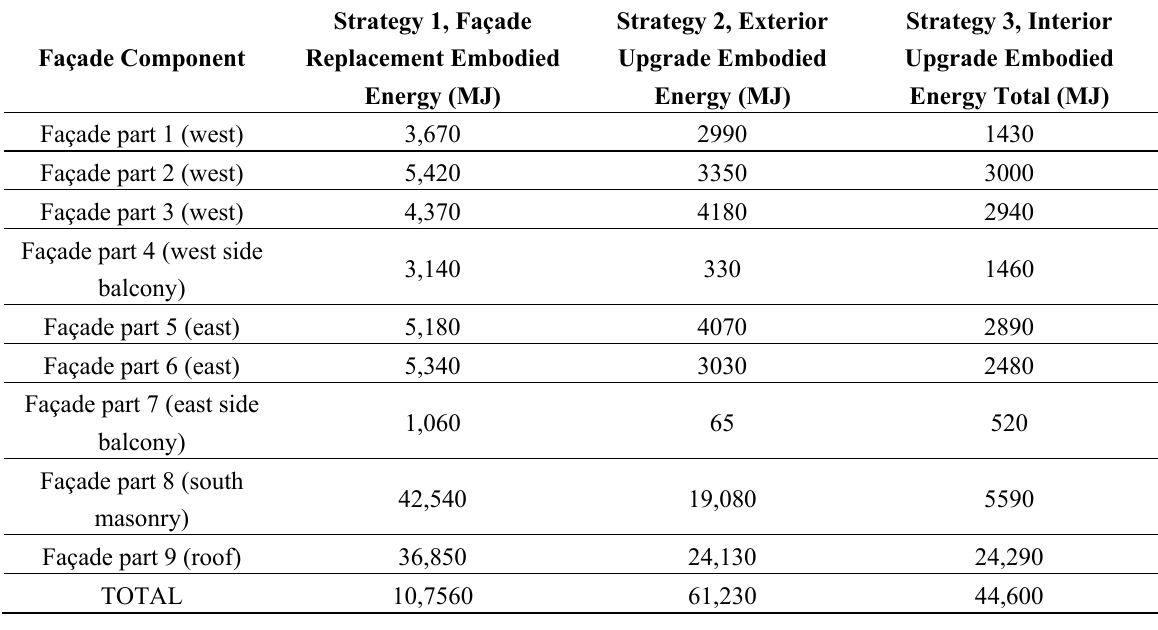
Table 3. Results of the strategy comparison per façade part for the Embodied Energy for a total of 35 years in MJ.